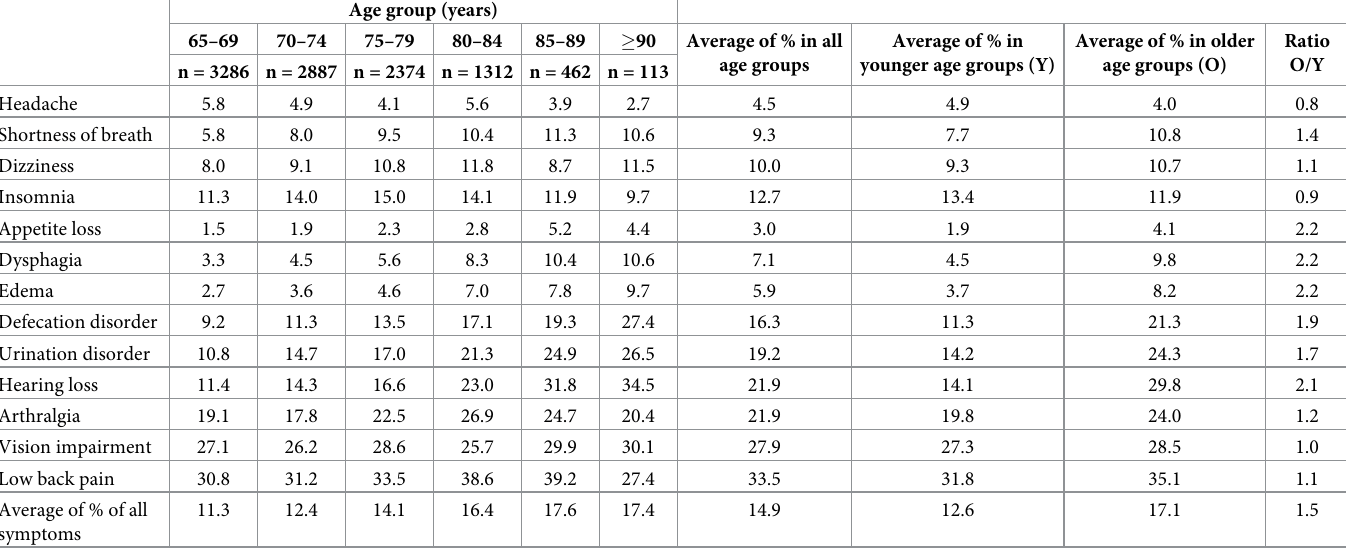
Table 2. Changes in the frequency of symptoms with